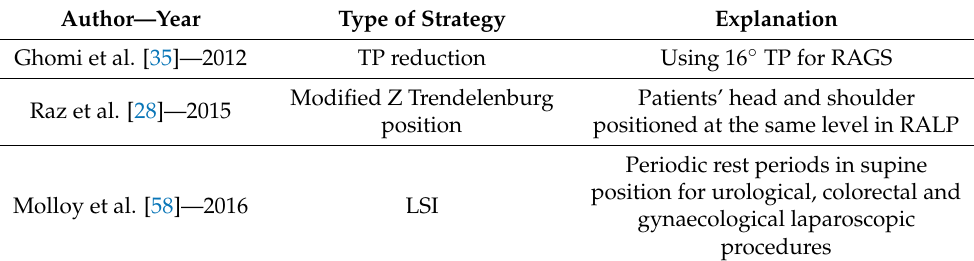
Table 2. Positional strategies to prevent increased IOP in